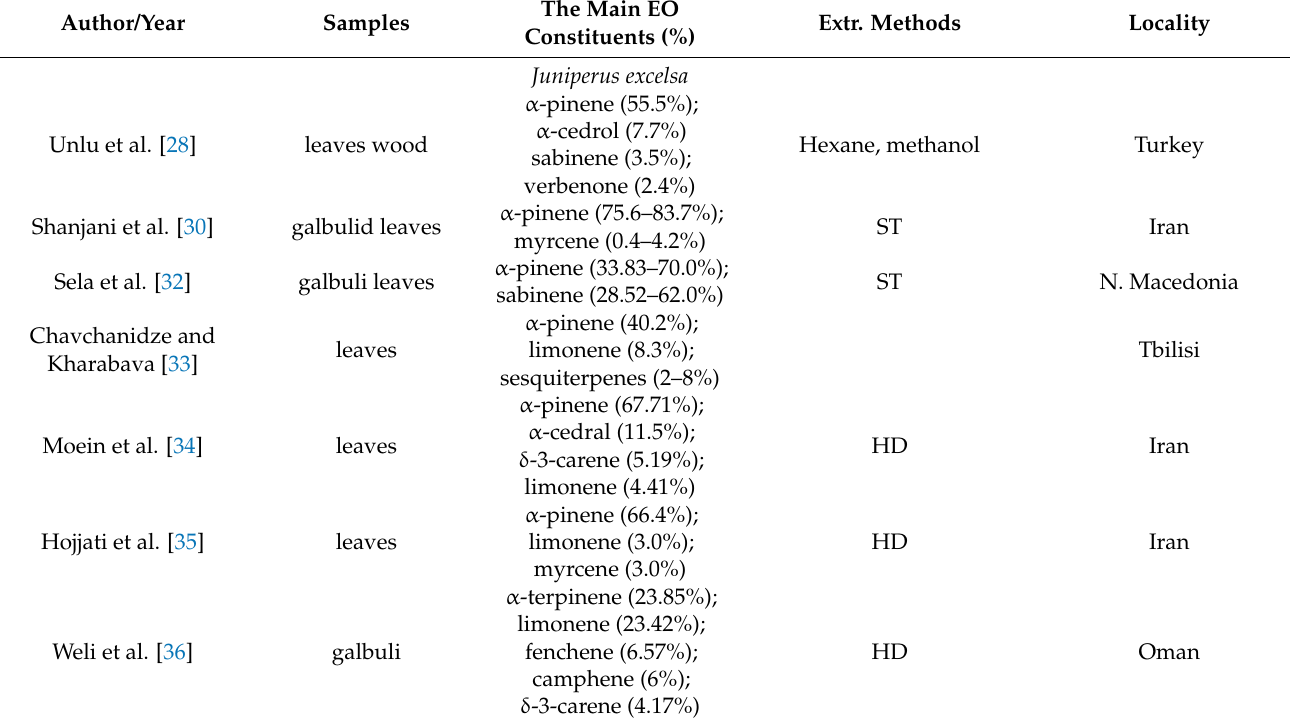
Table 1. Summarized data of the literature on the EO of J. excelsa and J. sabina